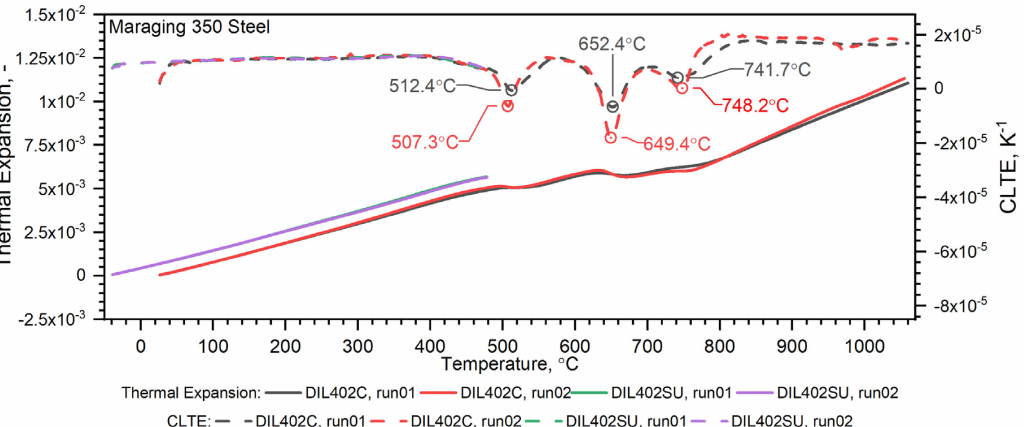
Figure 17. Thermal expansion and CLTE as a function of temperature for the Maraging steel obtained from the first and second heating runs on DIL 402 Expedis and DIL